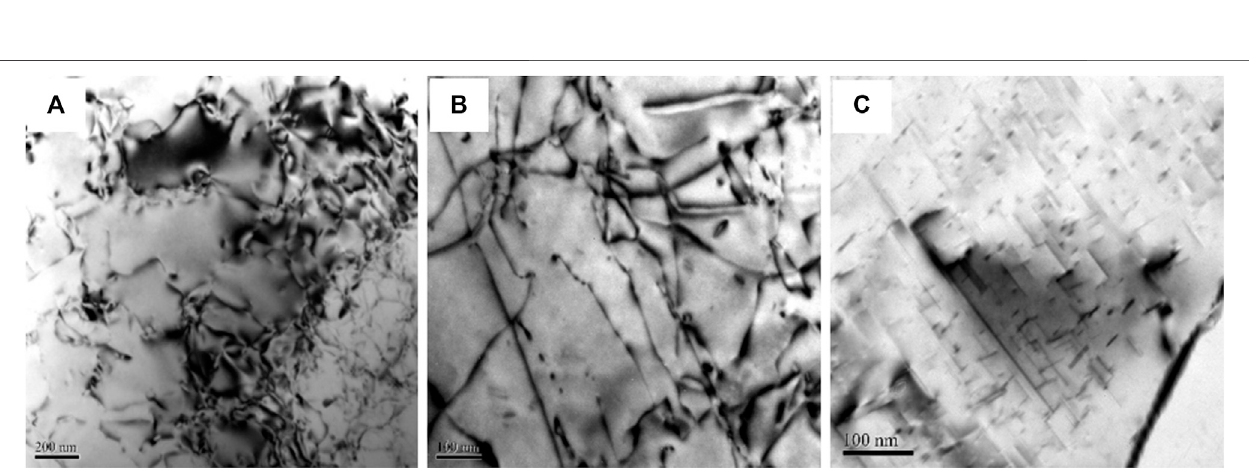
FIGURE 4 | The TEM image of the alloy in different conditions, (A) T1, (B) T4, (C) T6.